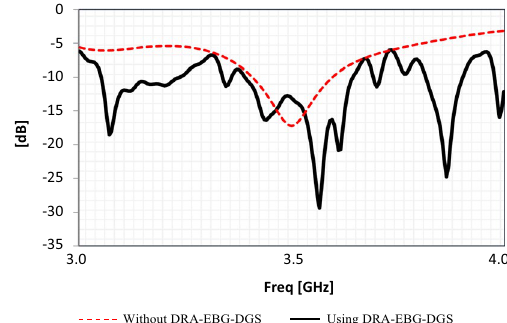
Fig. 7 Simulation result of S-parameter